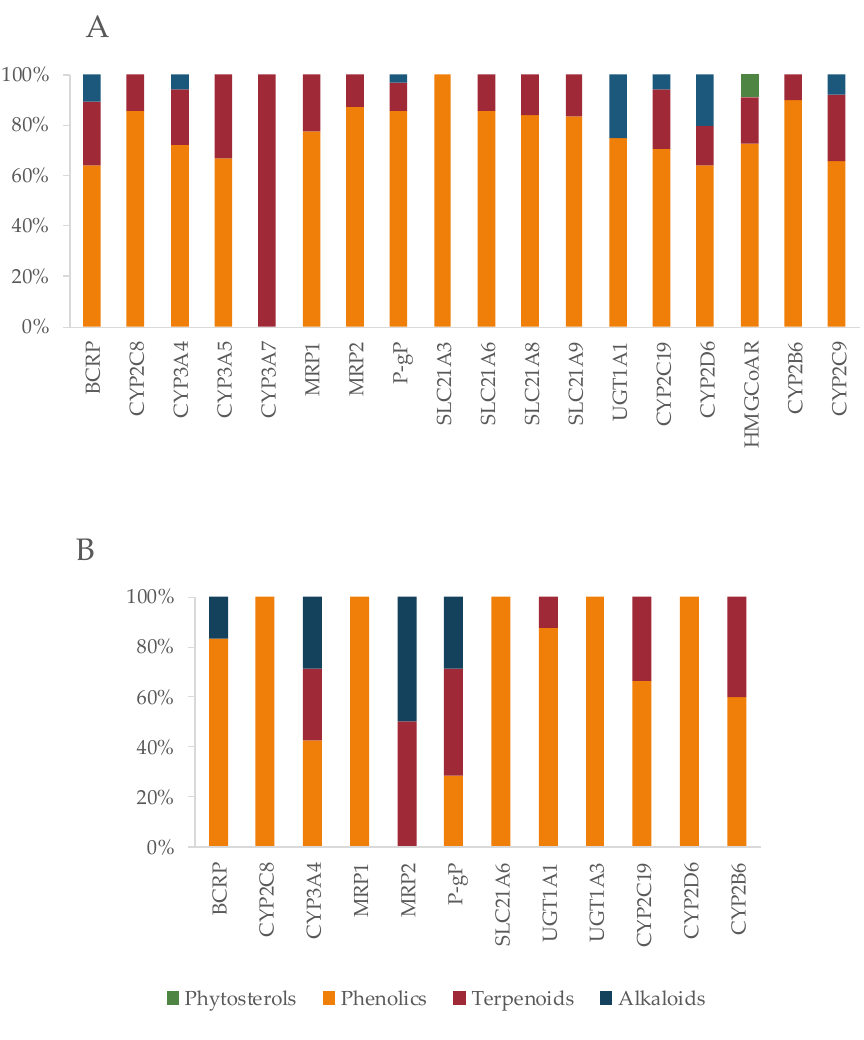
Figure 13. Characterization of the bioactives inhibiting ( A ) or inducing ( B ) At shared targets, according to chemical class.